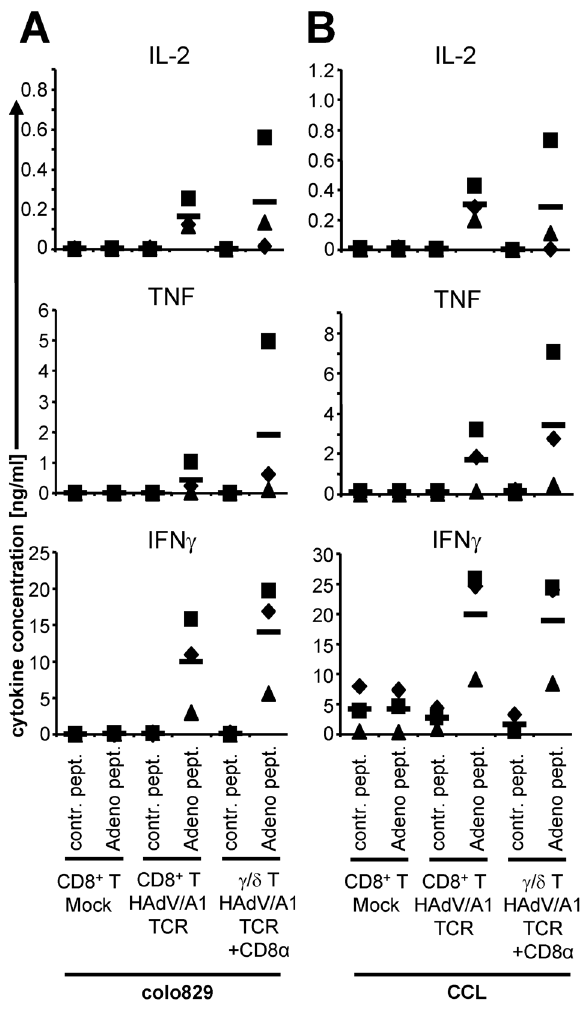
Figure 5. Direct comparison of cytokine production by HAdV/ A1-TCR-transfected CD8 + T cells and HAdV/A1-TCR-transfected c / d T cells. CD8 + T cells and c / d T cells of the same donors were either mock electroporated, electroporated with HAdV/A1-TCR-RNA alone, or electroporated with HAdV/A1-TCR-RNA and CD8 a -RNA. These cells were stimulated with colo829 cells ( A ) or CCL cells ( B ), which were either loaded with a control peptide (contr. pept.) or the adenovirus peptide (Adeno pept.). Cytokine concentrations (IL-2, TNF, and IFN c ) in the supernatant after overnight co-incubation are depicted. Data of 3 individual experiments are shown. Bars indicate mean values. Raw data are summarized in Table S5A and B in File S1.